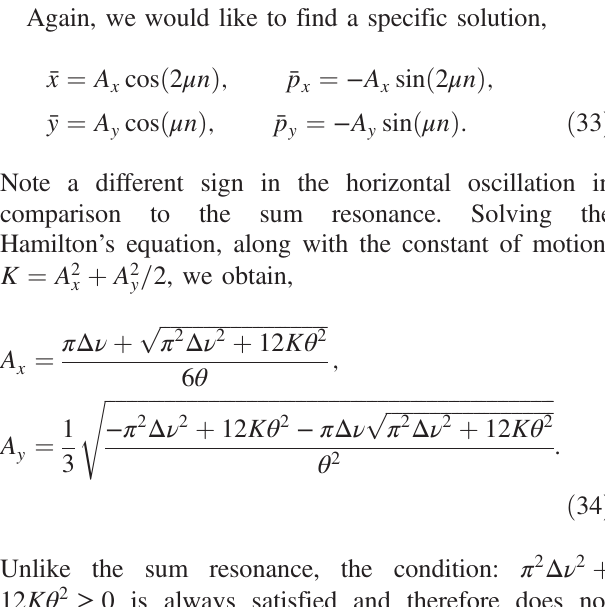
FIG. 15. A set of invariant tori in the normalized 4D phase spaces near the difference resonance: ν ν 0 . 314 . The red dots represent the orbits from tracking with bend length L ¼ 5 m and angle ϕ ¼ π = 64 and the blue lines are the y ¼ special solutions of the Hamiltonian in Eq. (31) with Δ ν ¼ − 0 . 01 and θ ¼ 72 . 81 m − 1 = 2